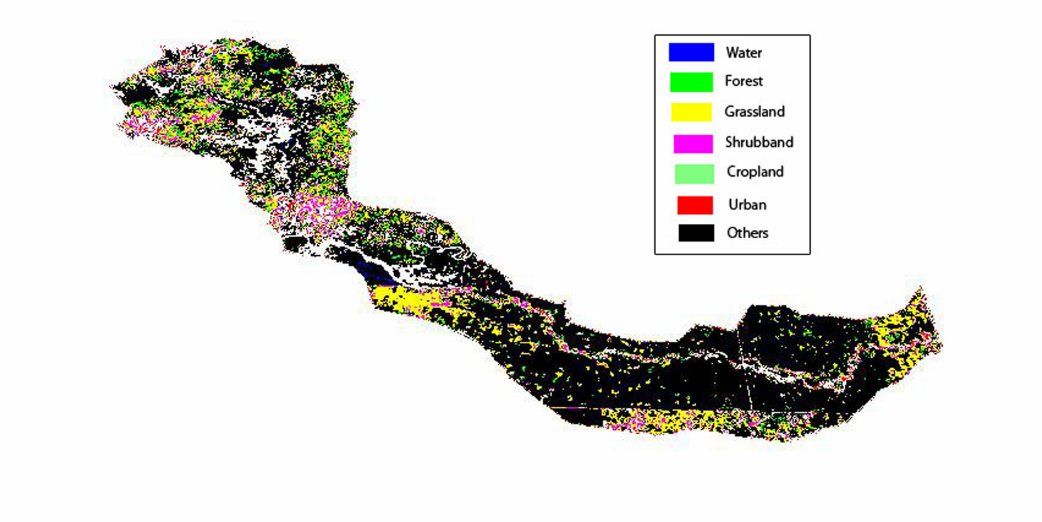
Figure 4: LULC classification of the chosen area following landcover.org